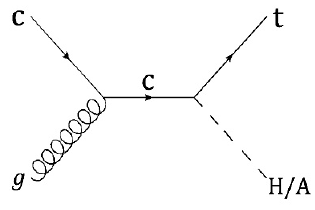
Figure 10 . Diagram that contributes to our monotop.